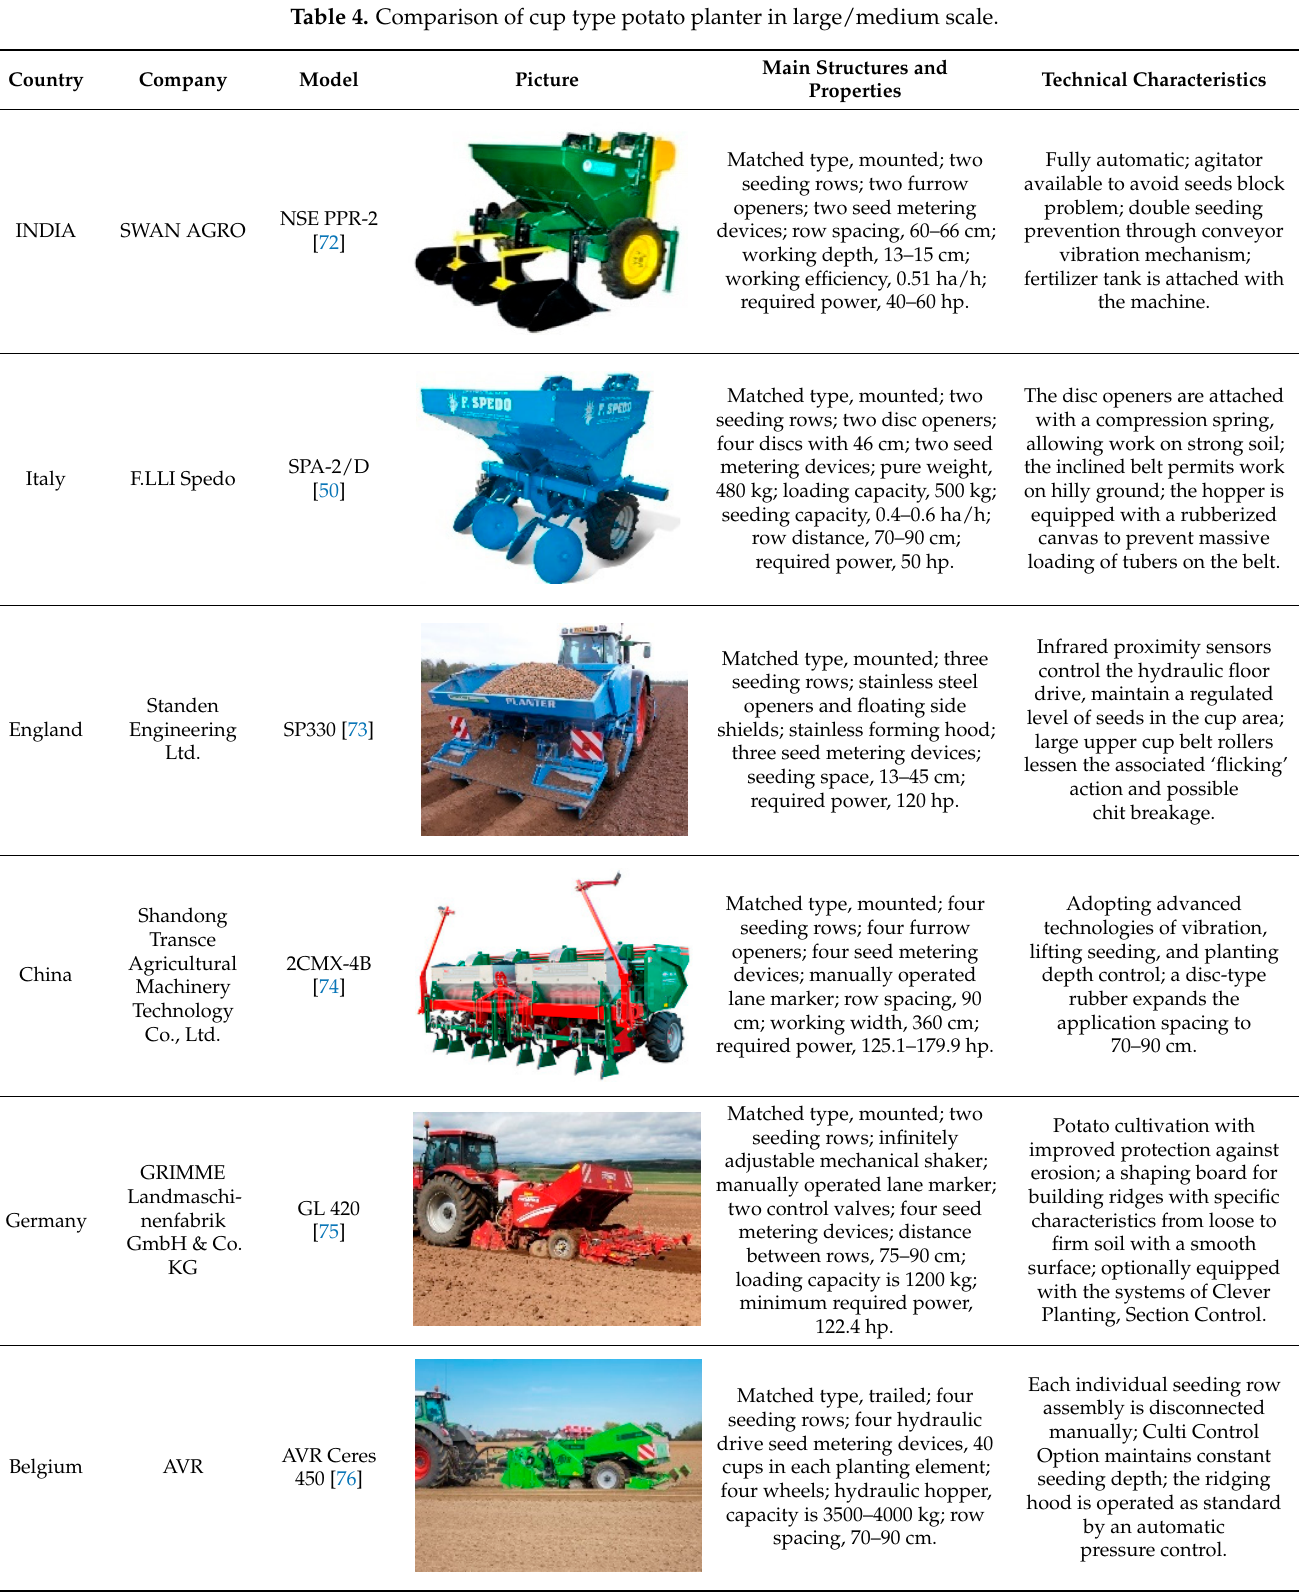
Table 4. Comparison of cup type potato planter in large/medium scale.